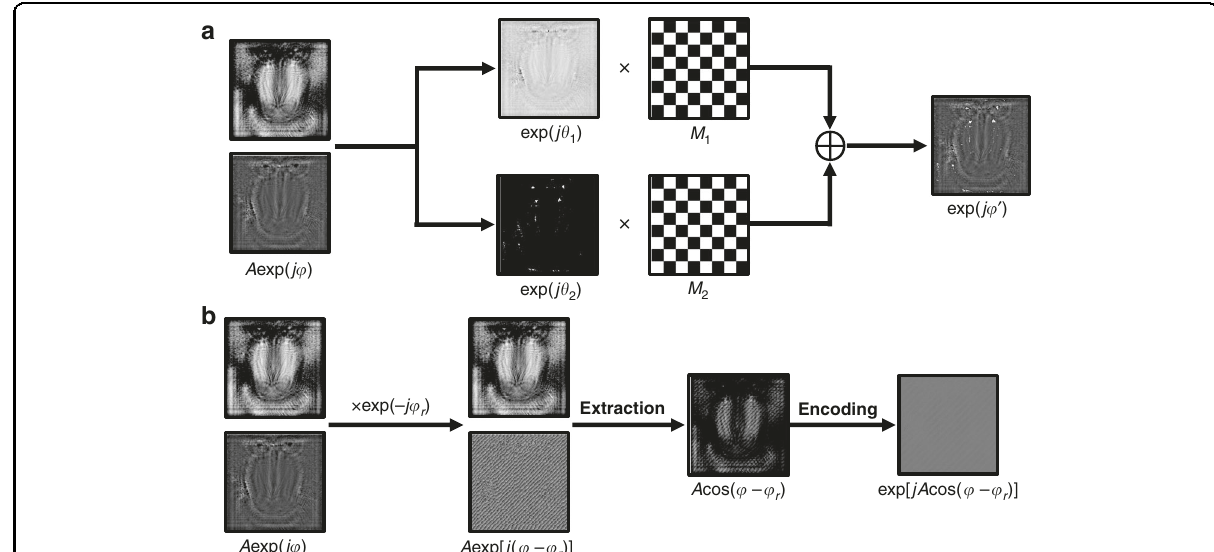
Fig. 7 Flowchart of encoding methods based on CAM. a DPH method based on single-pixel modulation; b hologram bleaching